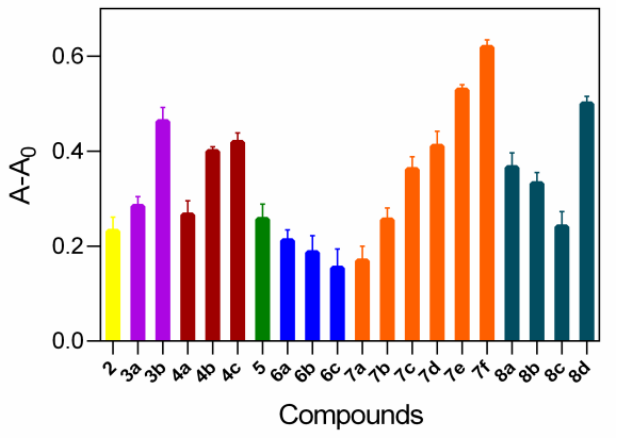
Figure 2. The supramolecular interactions of hydroxyethyl naphthalimides with DNA. (A: the absorbance of naphthalimides with DNA, A 0 : the absorbance of only DNA; Concentrations: 5 × 10 − 4 Table 1. In vitro antifungal activities as minimum inhibitory concentrations (MIC, µ g/mL) for hydroxyethyl